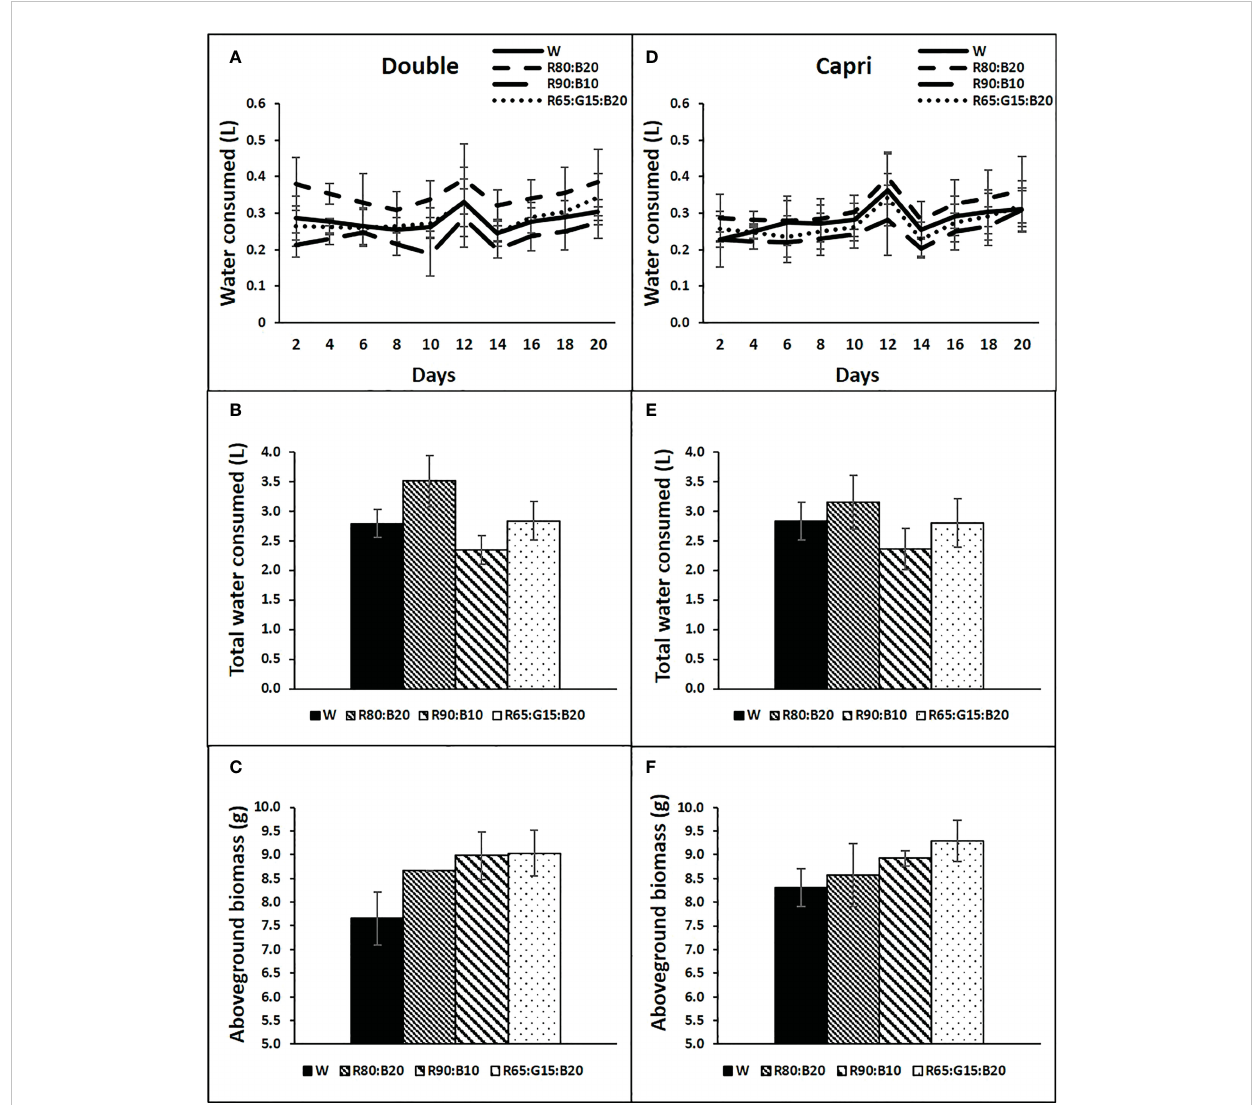
FIGURE 8 Water consumption by each tray of perennial ryegrass (cvs. Double, A – C and Capri, D – F ) after time zero, every two days (A, D) , accumulated at the end of the experiment (B, E) , and above ground biomass accumulated in each tray at the end of the experiment (g DW, C, F ), under different LED illumination regimes at 400 m mol m − 2 s − 1 , 100% cool white (W), 80% Red:20% Blue (R80:B20), 90% Red:10% Blue (R90:B10) and 65% Red:15% Green:20% Blue (R65:G15:B20). Each point and column are average and vertical bars represent the S.E. (n = 3). The absence of * indicated not statistically differences.